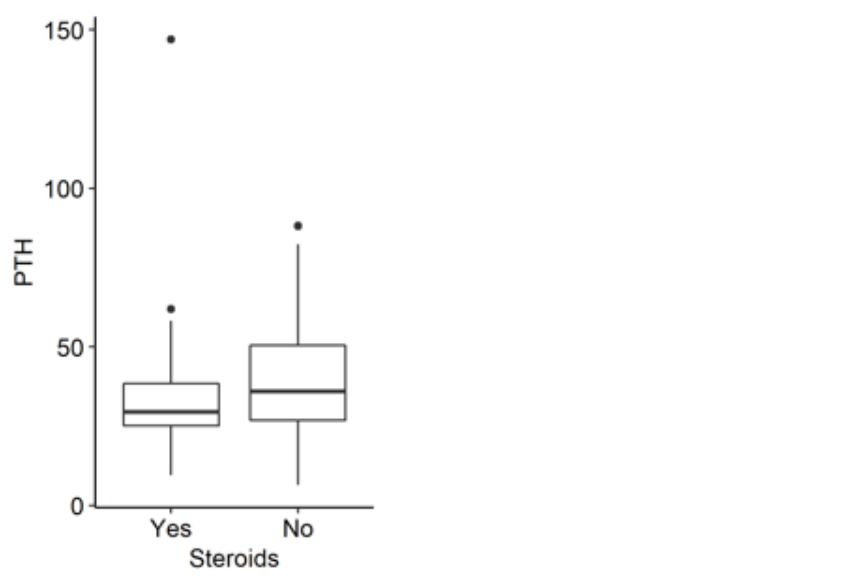
Figure 4. PTH levels in IBD patients with and without steroids ( p = 0.018). PTH: parathyroid hormone.